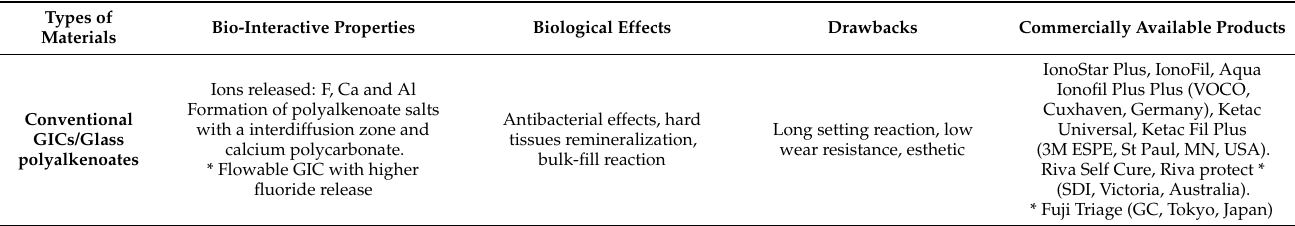
Table 1. Bio-interactive materials with their properties and commercially available brands (at the time of